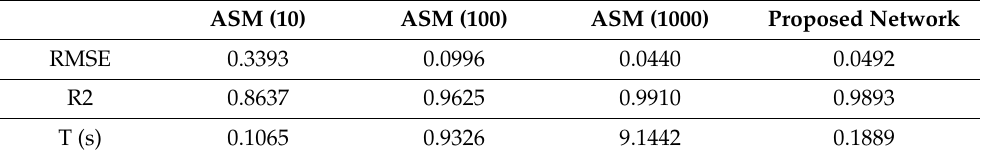
Table 1. Performance evaluation of different methods based on simple images.